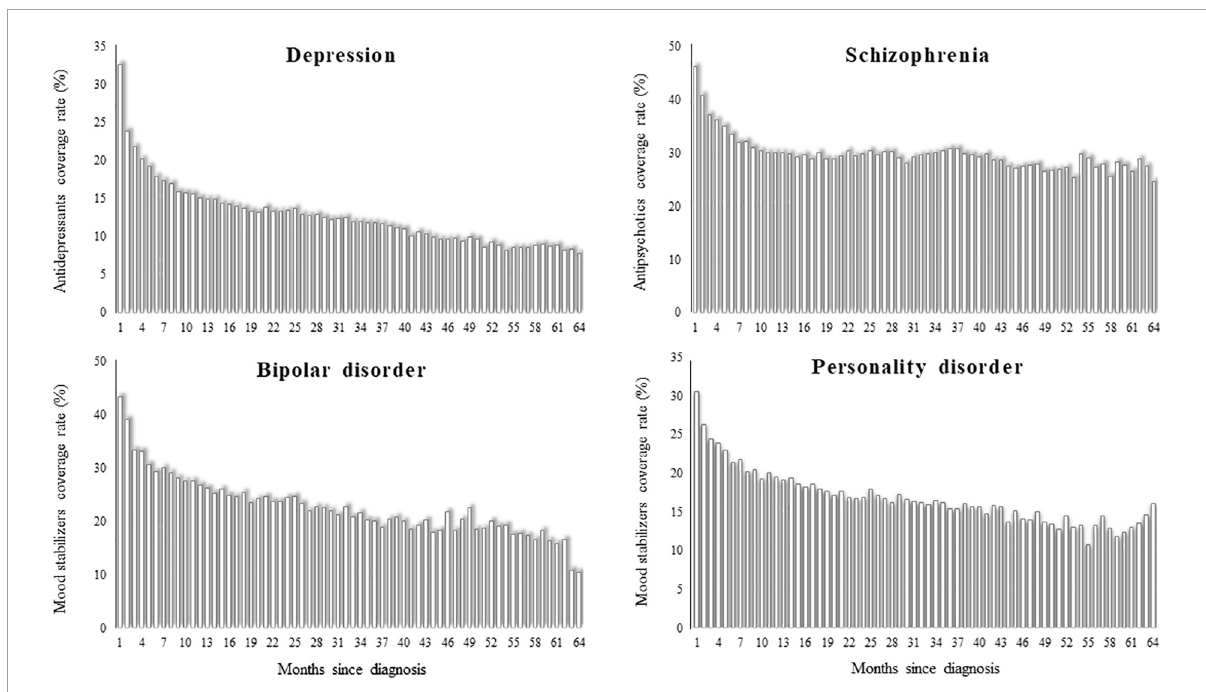
FIGURE2 Monthly coverage rate of drug therapy from the first until the 64th month after diagnosis of depression, schizophrenia, bipolar disorder, and personality disorder. QUADIM-MAP project, Italy,